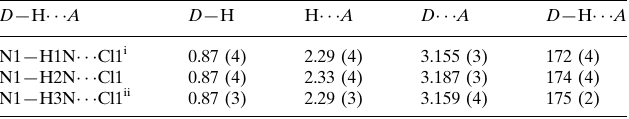
Hydrogen-bond geometry (A˚ , (cid:3)